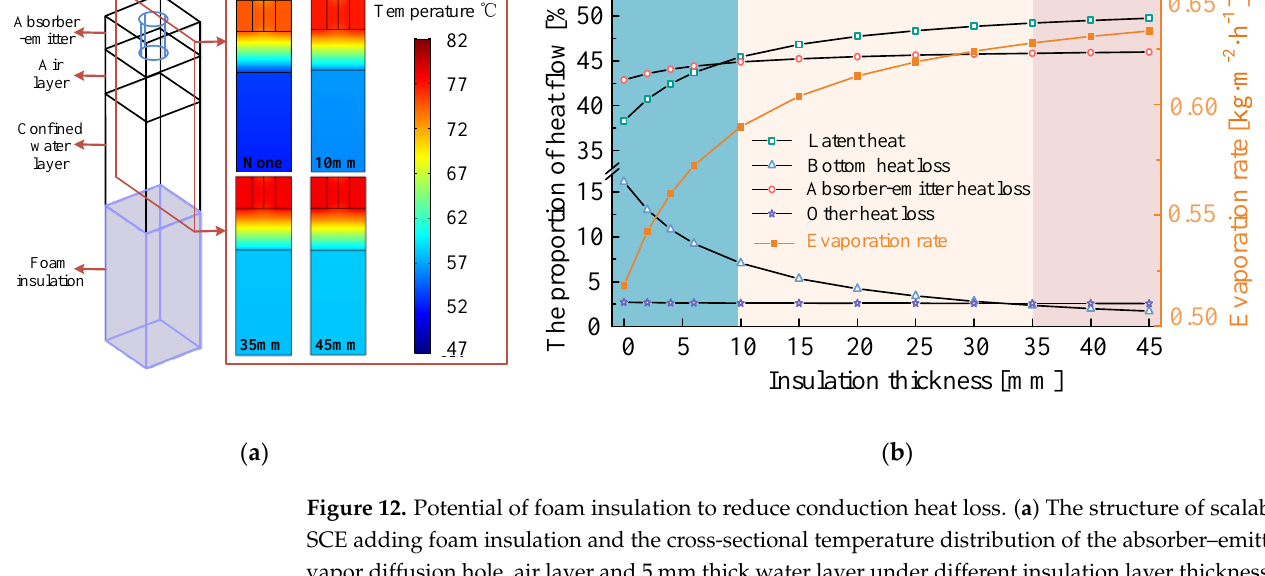
Figure 12. Potential of foam insulation to reduce conduction heat loss. ( a ) The structure of scalable SCE adding foam insulation and the cross-sectional temperature distribution of the absorber–emitter, vapor diffusion hole, air layer and 5 mm thick water layer under different insulation layer thicknesses of 0 mm, 10 mm, 35 mm and 45 mm. ( b ) The variation trends of energy distribution ratio and evaporation rate under different insulation layer thicknesses.